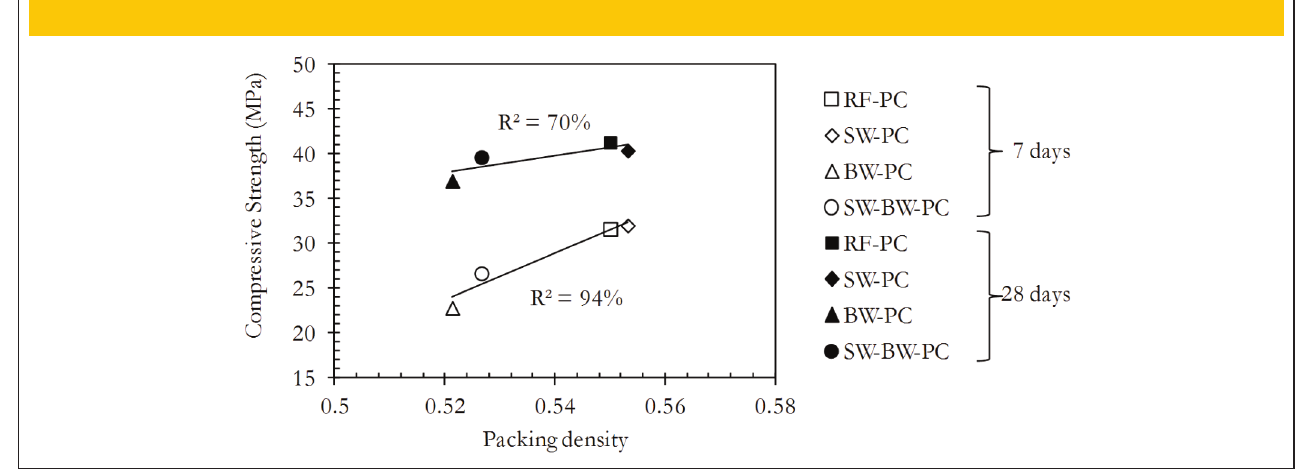
Figure 7 – Relationship of packing density and compressive strength of pastes for 7 and 28 days